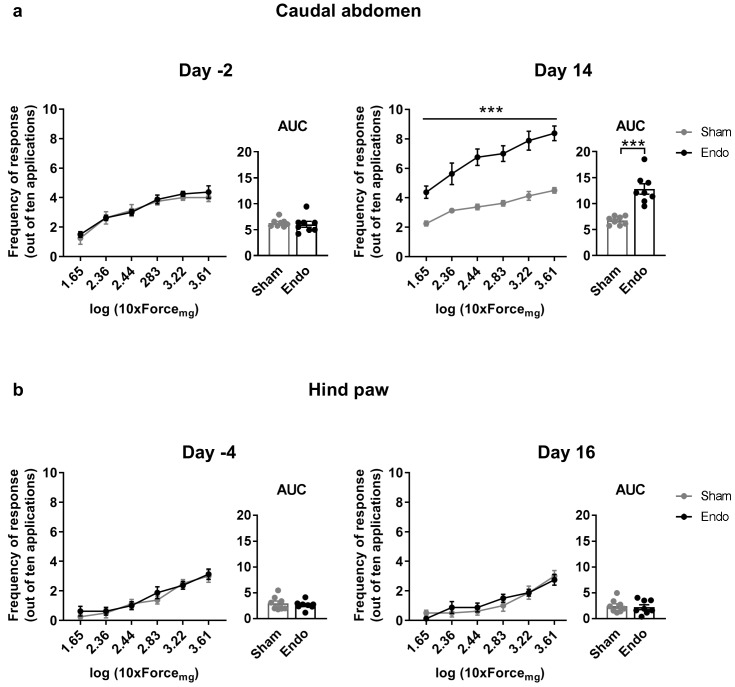
Nociceptive responses to abdominal and paw mechanical stimulation with von Frey filaments.(a) Frequency of responses to von Frey filaments applied against the caudal abdominal area and corresponding AUCs on day 14 after surgery were significantly higher in endometriosis mice when compared to sham mice. (b) Frequency of responses to von Frey filaments applied against the hind paw and corresponding AUCs were similar before and after surgery in endometriosis and sham mice. For each day, left panel is frequency of response to each von Frey filament and right panel is the corresponding mechanical sensitivity represented by the area under the curve of frequency of response to von Frey filaments. Higher values mean higher mechanical pain. Error bars are mean ± SEM. One-way repeated measures ANOVA (left panels) and Student t-test (right panels). ***p<0.001 vs sham. Endo, endometriosis; AUC, area under the curve.